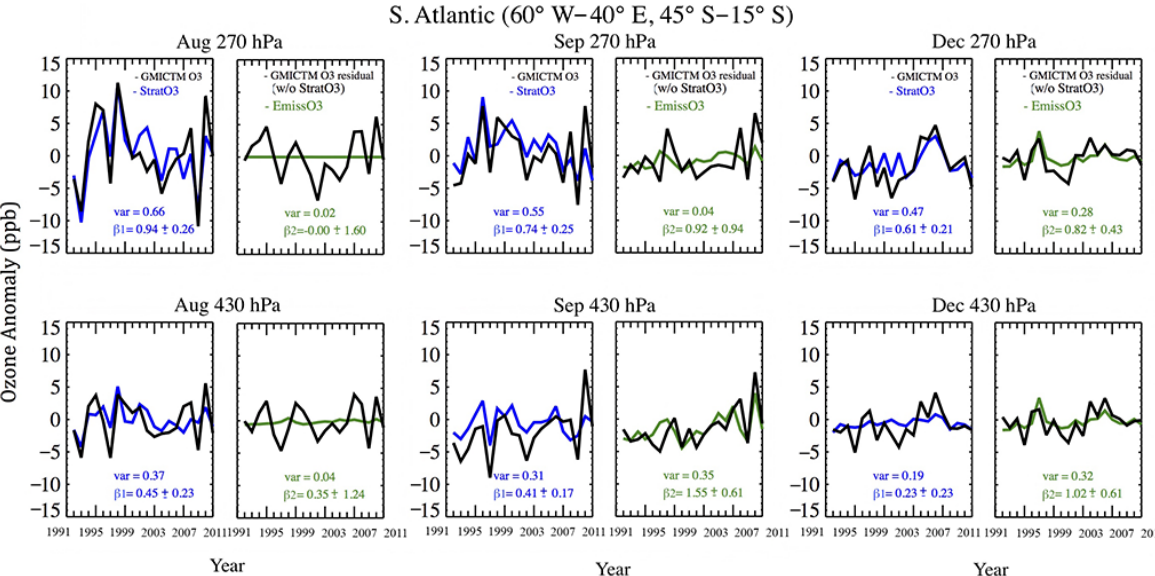
Figure 8. The multi-regression results of simulated ozone anomalies over the South Atlantic region relying on two predictor variables: StratO 3 (blue) and EmissO 3 (green) at 270 and 430hPa. Three panels show results from August (left), September (middle), and Decem- ber (right) from 1992 to 2011. Each panel contains two columns. The left column of each panel compares the anomalies of StratO 3 (blue) and simulated ozone mixing ratio (black) from the GMI-CTM model at 270 and 430hPa. The right column compares the simulated O 3 residual after removing the regression from StratO 3 (black line) and EmissO 3 (green line) at these two levels. EmissO 3 is calculated from the difference of simulated ozone between the run with yearly-varied emission and the run with constant emission. Unit for y axis is parts per billion (ppb). The variance explained by each predictor (var), regression coefficient ( β) , and its 95% confidence level are labeled in each